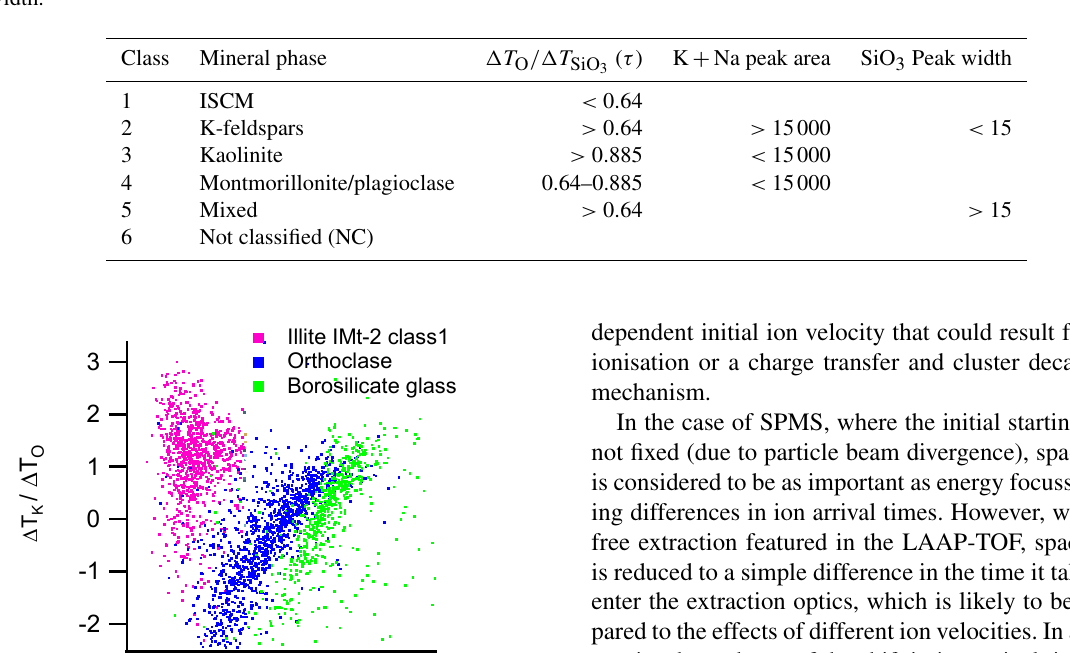
Table 9. Single-particle mineral-phase classification scheme based on τ , combined potassium and sodium content, and SiO 3 molecular ion peak width.